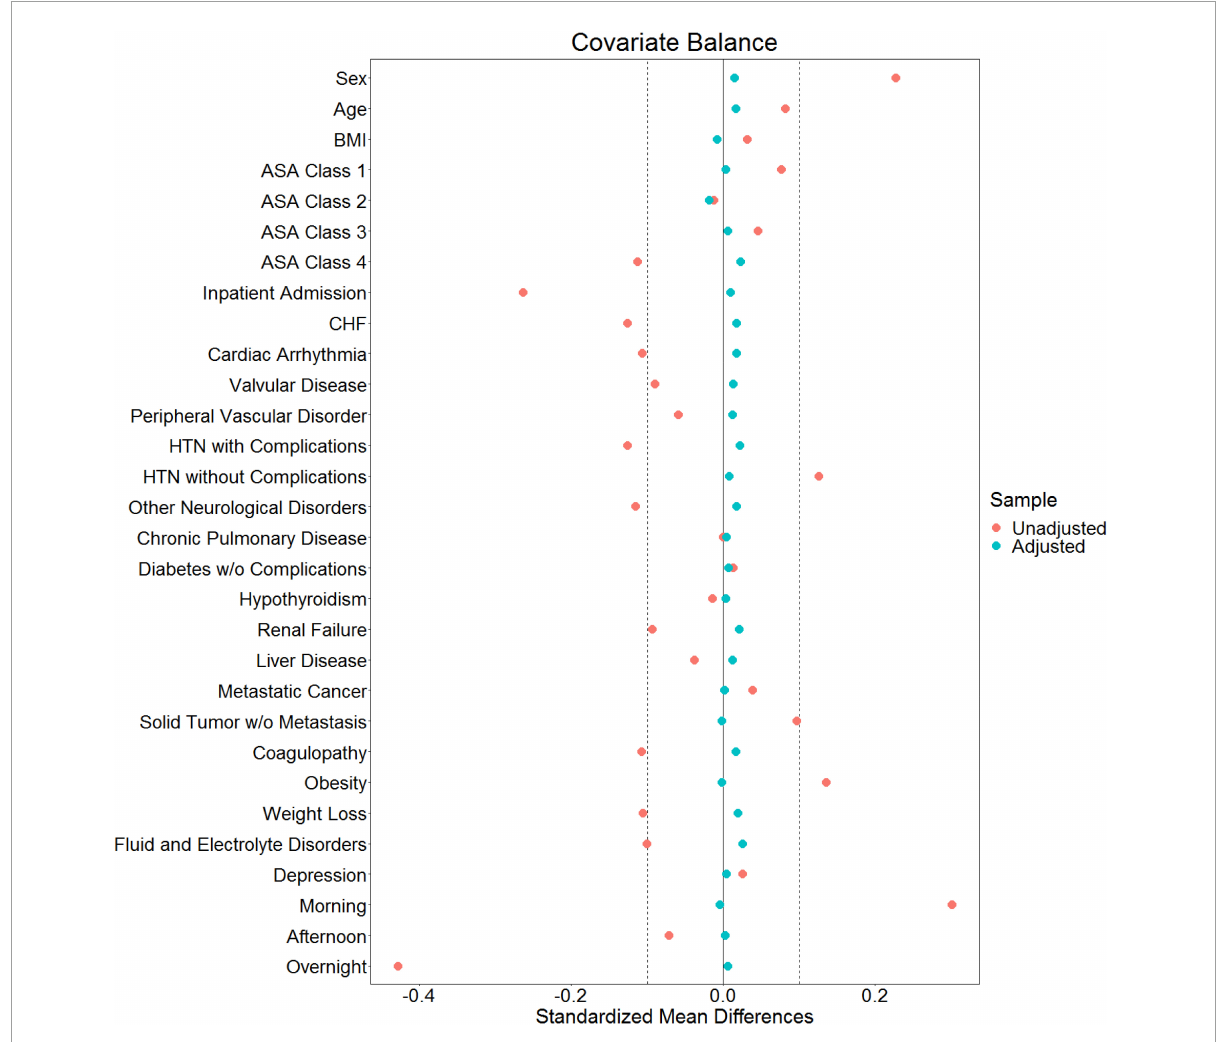
FIGURE4 Love plot showing baseline imbalances for the covariates of interest and the effectiveness of balancing via the inverse probability of treatment weights.